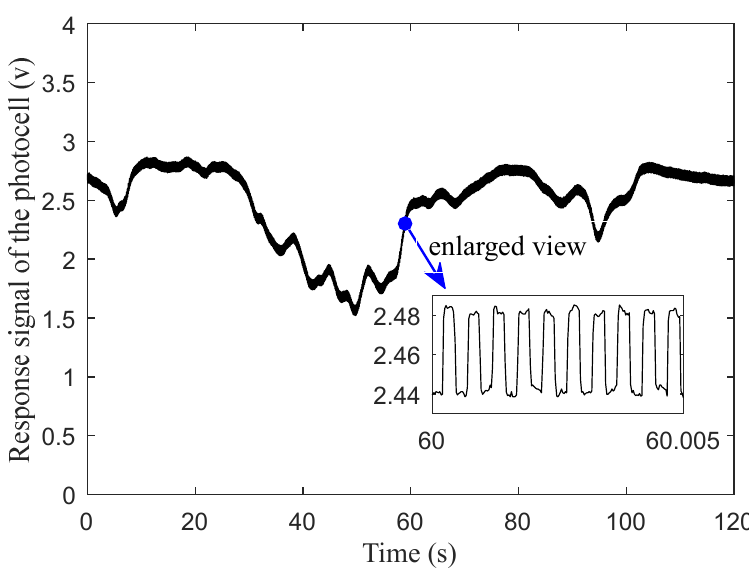
Figure 4. Response signal of the photocell to the superposition of active light and sunlight.